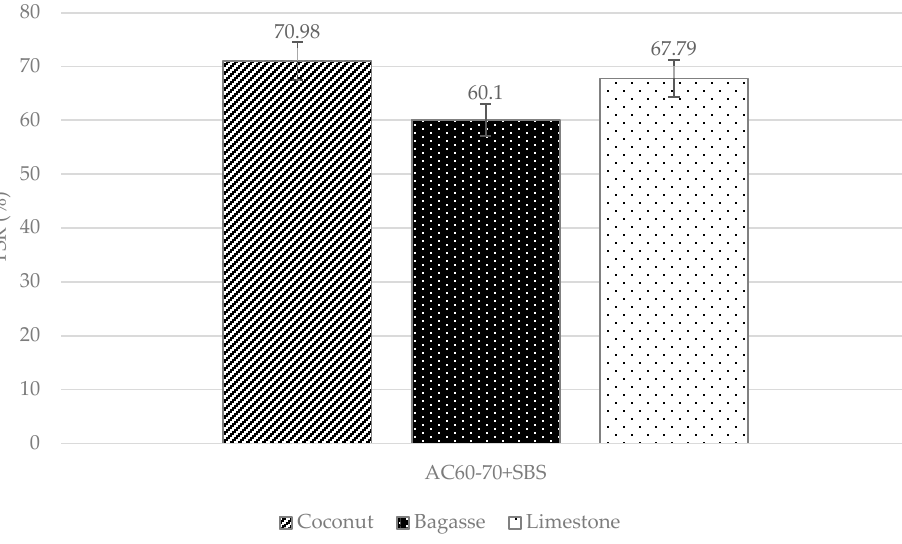
Figure 8. TSR in porous mixture samples.